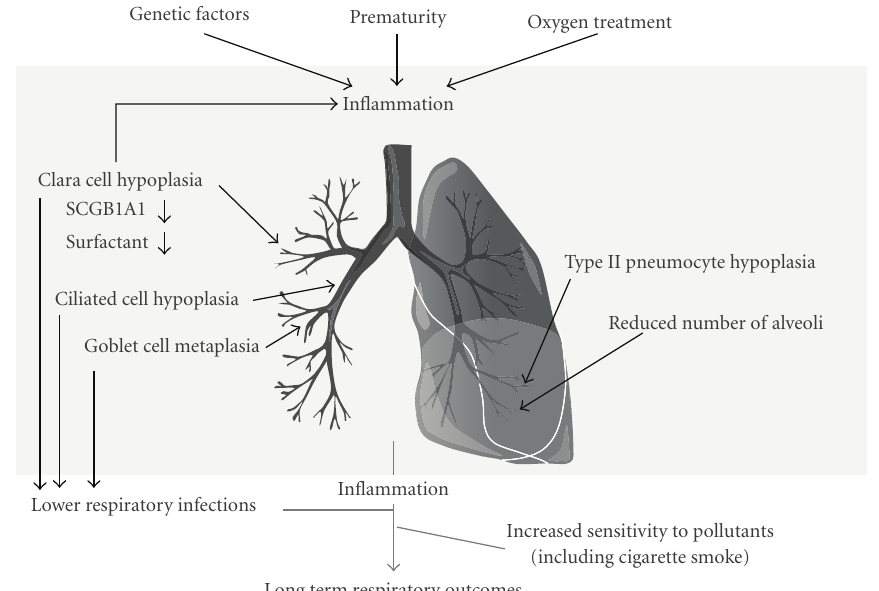
Figure 1: A proposed model for how airway epithelial maturation influences BPD and long term respiratory outcomes of prematurity. Prematurity, oxygen treatment, and genetic factors contribute to the pathology of bronchopulmonary dysplasia (BPD). Impaired epithelial maturation leads structural changes, disturbed epithelial homeostasis, and inflammatory responses and increased susceptibility to infections. Early life events such as lower respiratory infections and exposure to air born pollutants likely aggravate inflammatory processes initiated by